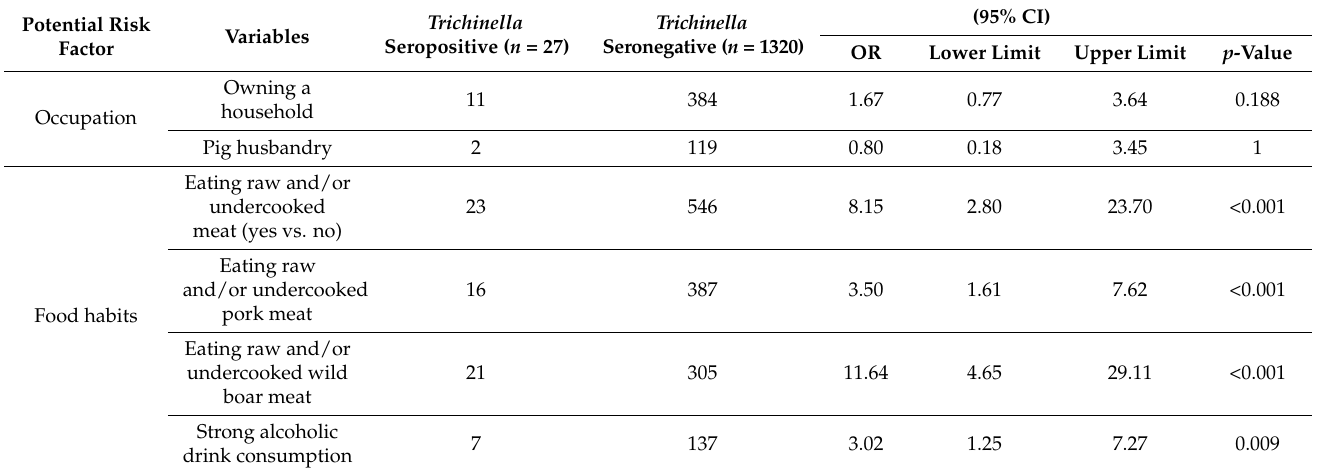
Table 2. Risk factors for Trichinella infectionin blood donors ascertained by